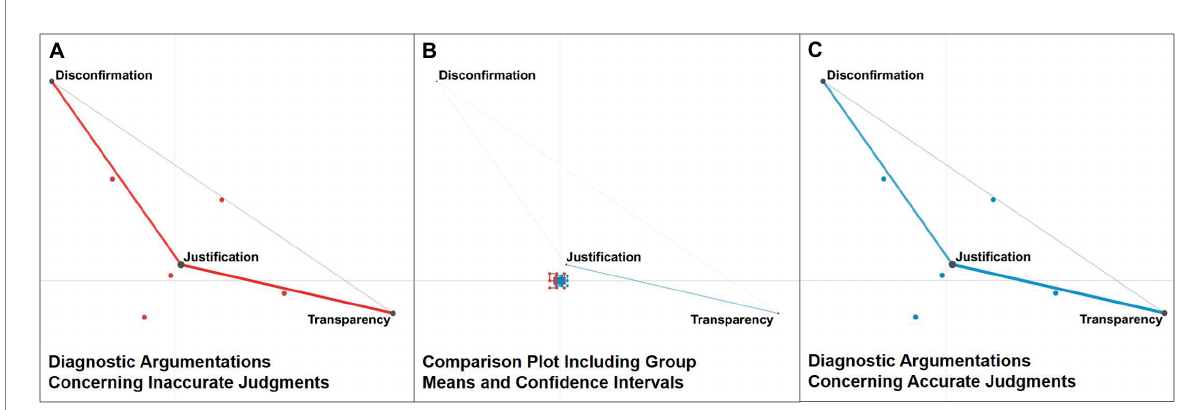
FIGURE 4 Networks across diagnostic argumentation texts, grouped by diagnostic accuracy and rotated by group means: (A) shows the network of diagnostic argumentation texts concerning inaccurate judgments. (C) shows the network of diagnostic argumentation texts concerning accurate judgments. (B) shows the comparison plot, which depicts the differences between the other two networks, as well as the group means (indicated by colored squares) and confidence intervals (indicated by colored dashed boxes) of the other two